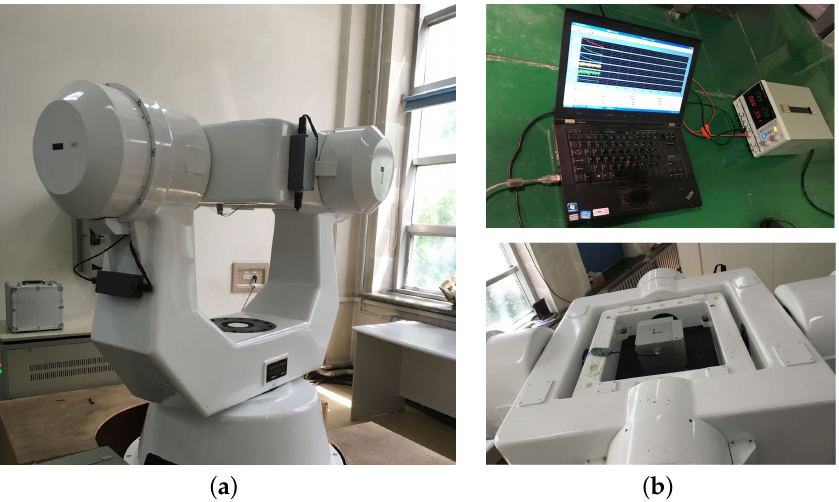
Figure 15. Test environment establishment. ( a ) Three-axis test turntable. ( b ) Test IMU and data collection